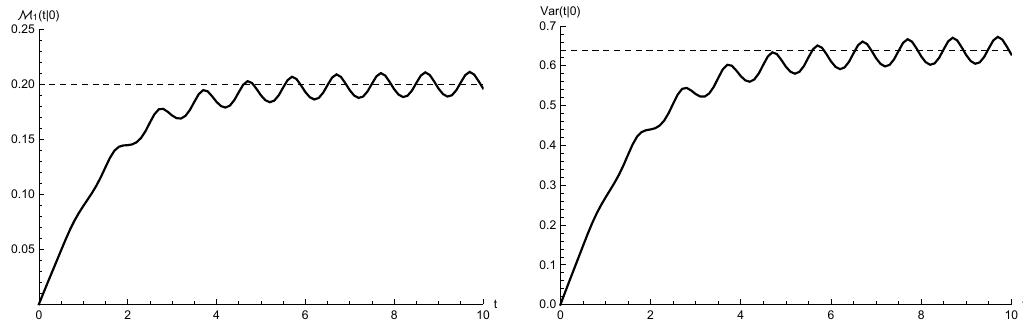
Figure 4. On the left: p 0 ( t | 0 ) and steady-state probability p ∗ curve) and p 1 ( t | 0 ) (red curve), with steady-state probabilities p ∗ − The parameters are specified in Example 1.